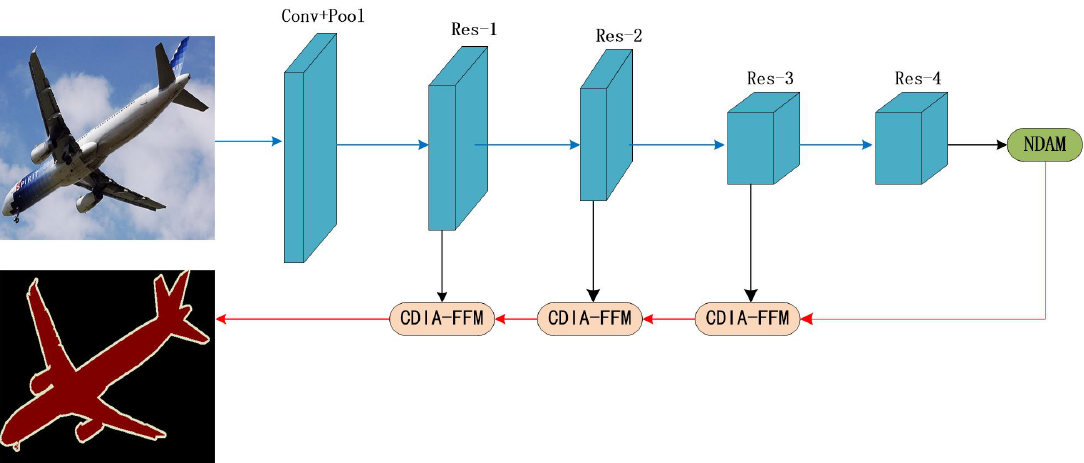
Figure 2. Overview of MANet for semantic segmentation. We use ResNet101 to extract dense features. We use NDAM to effectively capture long-distance contextual information and use CDIA-FFM to fuse features at different stages. The blue and red lines represent the downsample and upsample operators,